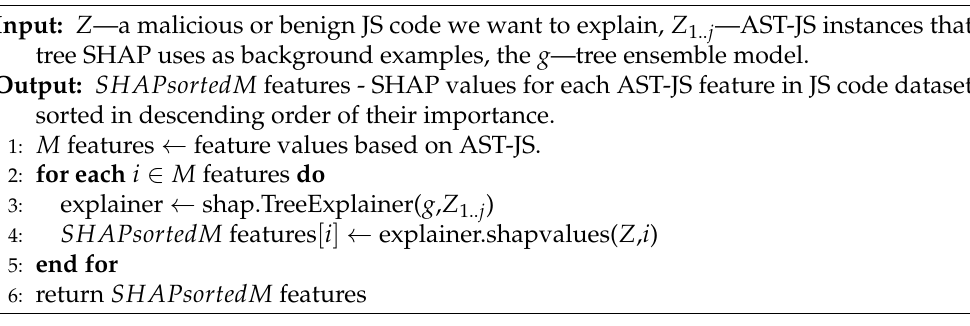
Algorithm 2 Calculating tree SHAP values for AST-JS M features.